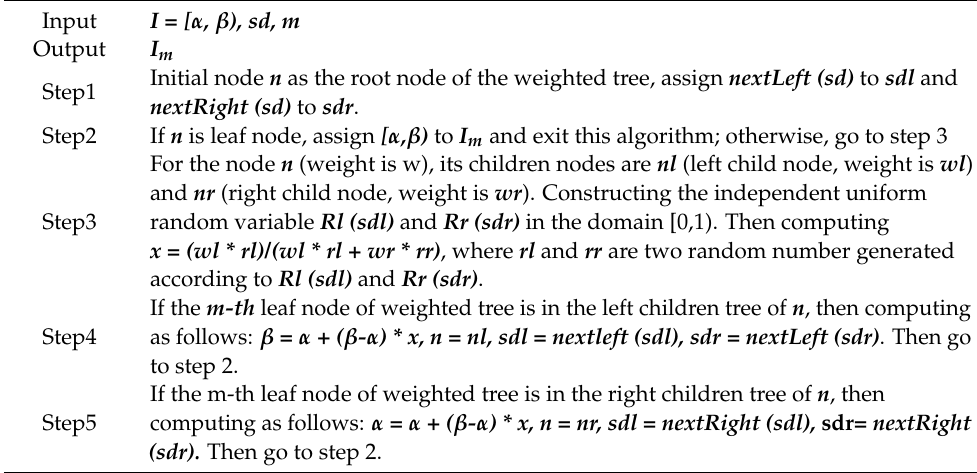
Algorithm 1: The weighted random interval division algorithm